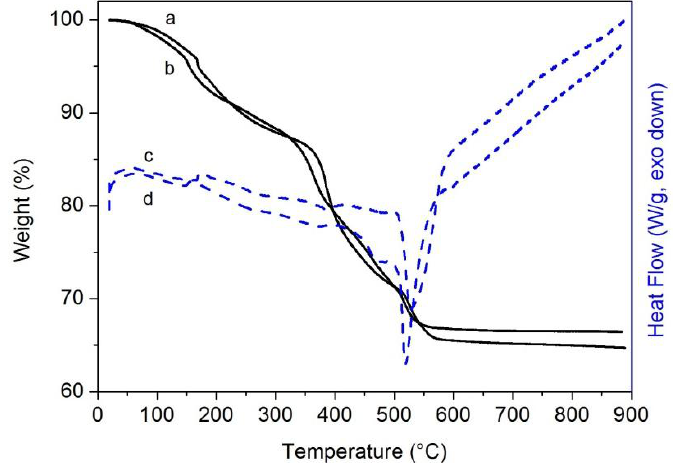
Figure 3. TGA (continuous lines) and DSC (dashed lines) curves of Geo-Epojet20 (a,c) and Geo-EpojetLV20 (b,d) specimens cured at room temperature for seven days in 99% relative humidity